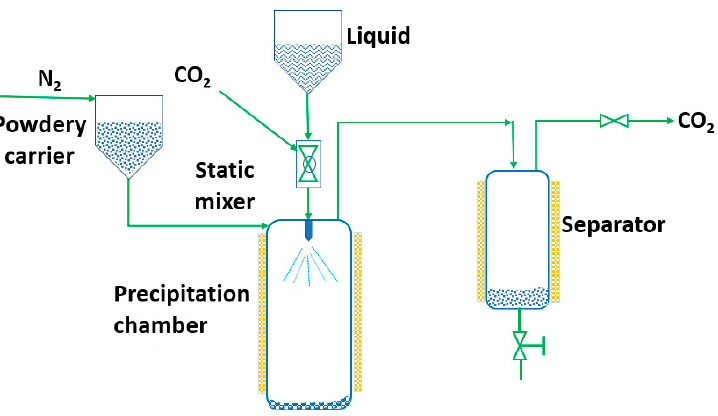
Figure 5. Concentrate Powder Form (CPF) process (adapted from Vorobei and Parenago [141]). Continuous Powder Coating Spraying Process (CPCSP)